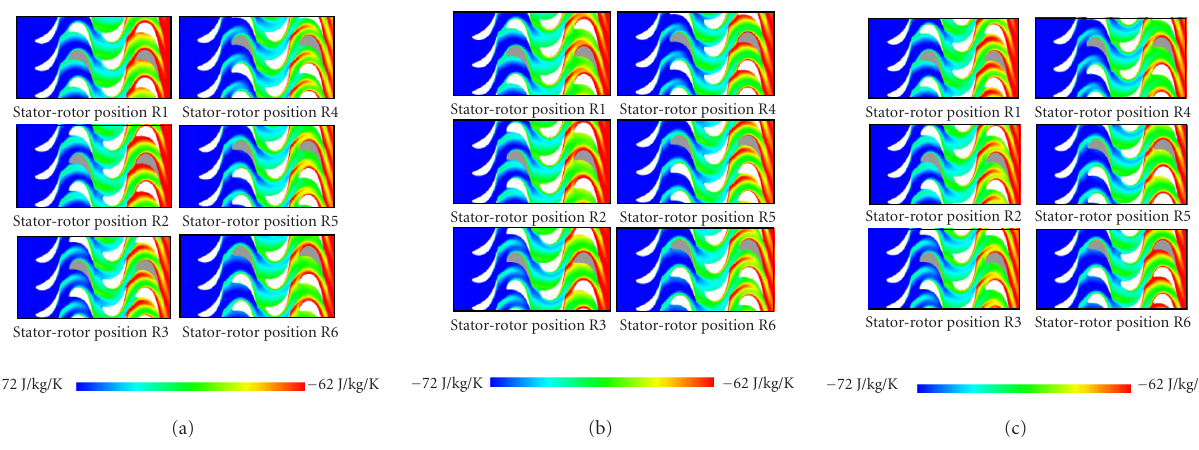
Figure 3: Entropy distributions in the steady calculations (frozen rotor approach): (a) clocking position S1, (b) clocking position S2, and (c) clocking position S3.